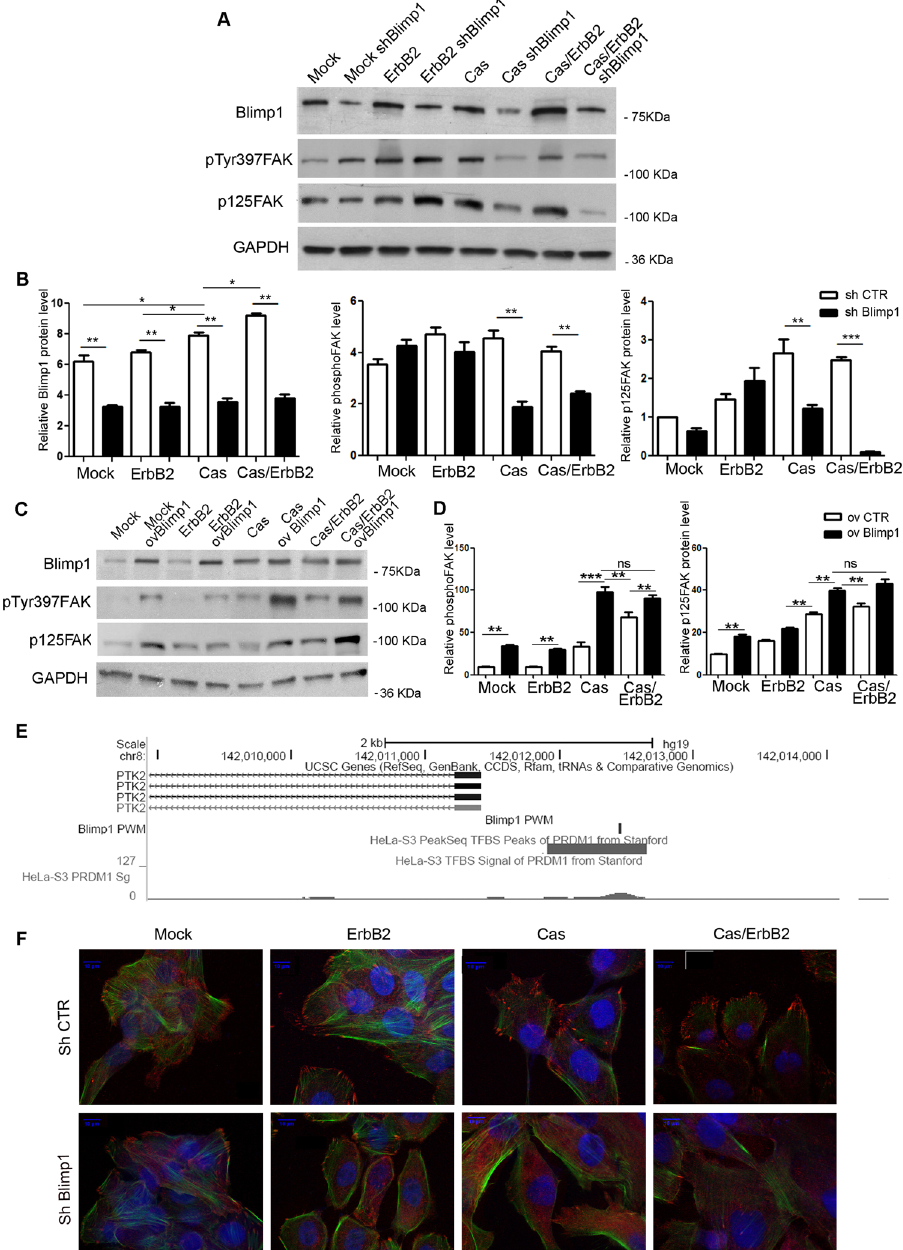
Figure 3. Focal adhesion protein expression is altered upon Blimp1 silencing. ( A ) Mock and Cas cells were transduced with the sh Blimp1 vector and treated with 1 µ M AP1510 for 48 hours. Total cell extracts were probed for Blimp1, phospho-p125Fak(Tyr397), p125FAK, in a western blot analysis. GAPDH was used as the loading control. ( B ) Densitometric analysis of protein levels in at least three independent experiments is shown (mean ± s.e.m). Protein modulation was calculated relative to Mock level and normalized to GAPDH as the loading control. Statistical analyses were performed using the Student’s t-test ( * p < 0.05, ** p < 0.01, *** p < 0.001). ( C ) Mock and Cas cells were transduced with Blimp1 overexpressing vectors and treated or not with 1 µ M AP1510 for 48 hours. Total cell extracts were probed for Blimp1, phospho- p125Fak(Tyr397) and p125FAK in a western blot analysis. GAPDH was used as the loading control. ( D ) Densitometric analyses of protein levels in at least three independent experiments are shown (mean ± s.e.m). Phospho-p125Fak(Tyr397) and p125FAK modulation was calculated relative to Mock level and normalized to GAPDH as the loading control. Statistical analyses were performed using the Student’s t-test ( ** p < 0.01). ( E ) The core promoter of PTK2 (FAK) harbors a Blimp1 PWM match (rectangle) with a log-likelihood of 13.79, in correspondence with a ChiP-seq peak identified in the HeLa cells. ( F ) Immunofluorescence staining for vinculin (red) and phalloidin (green) of Mock and Cas MCF10A.B2 treated or not with 1 µ M AP1510 for 48 hours. Scale bars: 10 µ m. Magnification